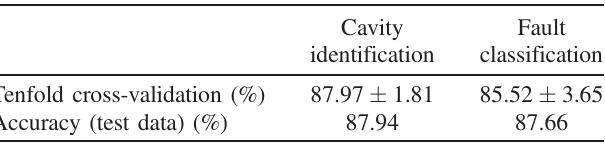
TABLE II. Cross-validation and accuracy scores for each random forest model. The accuracy scores were generated by applying the model on the withheld test